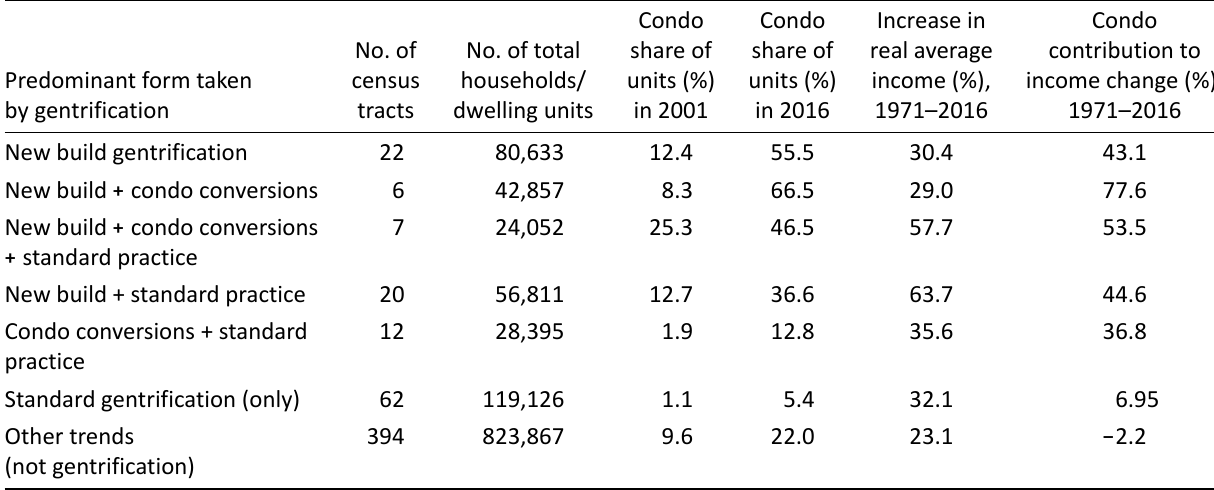
Table 2. Condoization and